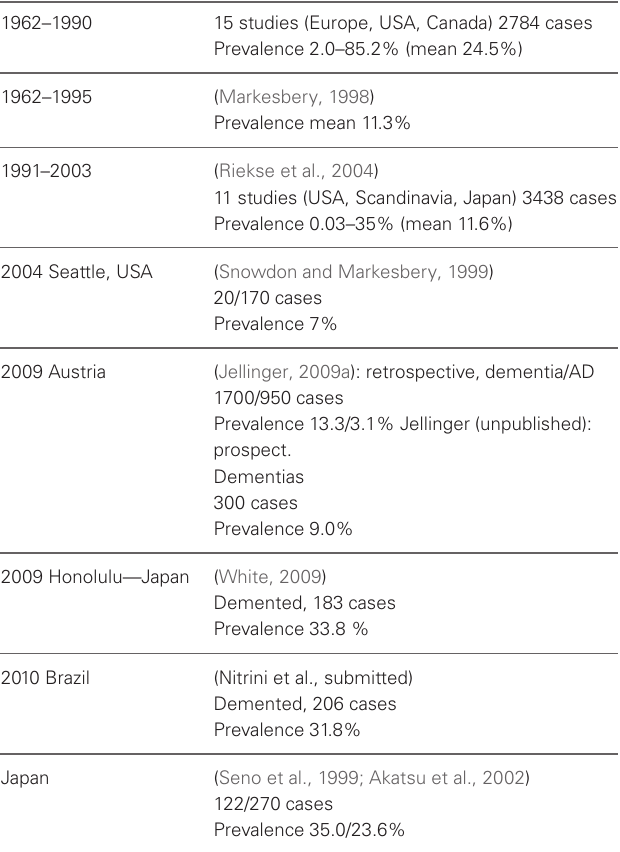
Table 3 | Autopsy series showing prevalence of VaD/VCI [modified from Jellinger